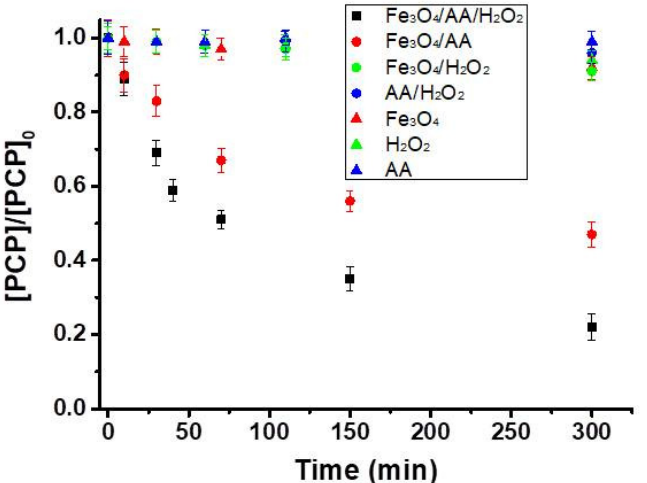
Figure 2. PCP removal in the single, binary, and ternary systems with 20 mg L − 1 of PCP using 0.5 g L − 1 of magnetite, 4 mM of ascorbic acid, and 4 mM of H 2 O 2 at pH 7.2 (total solution volume = 100 mL). [PCP] represents the PCP concentration after oxidation at a specified oxidation time, and [PCP] 0 is its concentration at t = 0 (before treatment) determined by HPLC.